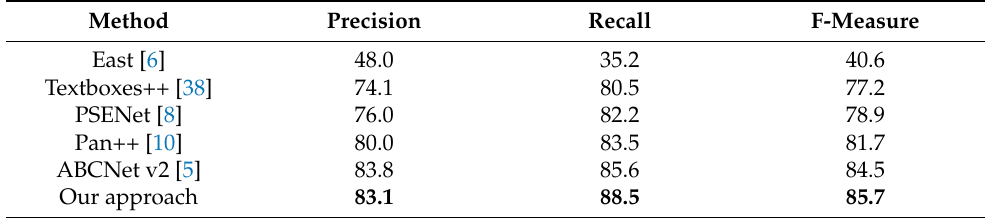
Table 3. Detection comparison with state-of-the-art methods on the CTW1500 dataset.